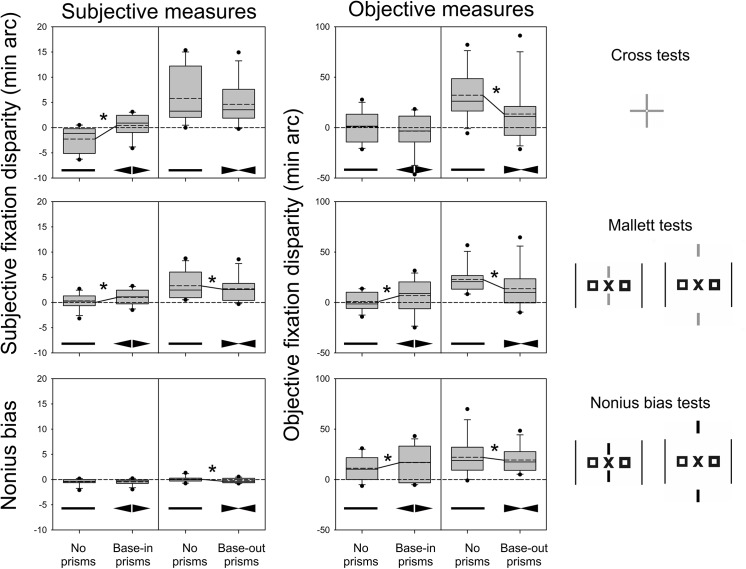
Subjective and objective measures for the three types of tests measured with and without prisms.Box-plots are presented separately for base-out and base-in prisms. Positive and negative values mean an over-convergence (eso) or under-convergence (exo), respectively. In each box, the line indicates the median and the dotted line the mean. Significant mean prism effects are indicated by an asterisk and a line that connects the two mean values. Each box represents 12 participants.